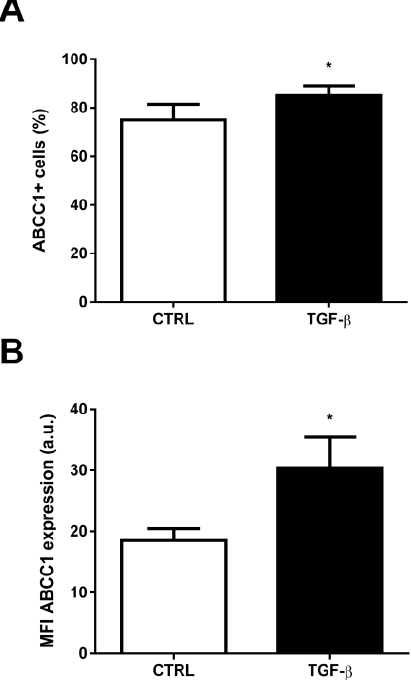
Figure 6. TGF- β -induced epithelial-mesenchymal transition (EMT) increases ABCC1 expression. A549 cells (1 × 10 5 cells/mL) were incubated with 5 ng/mL TGF- β for EMT induction. After 48 h, the cells were stained with anti-ABCC1 antibody and ( A ) percentage of positive cells and ( B ) protein expression were evaluated by flow cytometry. Expression is represented by median fluorescence intensities (MFI). Bars represent mean + SEM, and the values of significance were represented by (*) for p < 0.05 from four independent experiments.